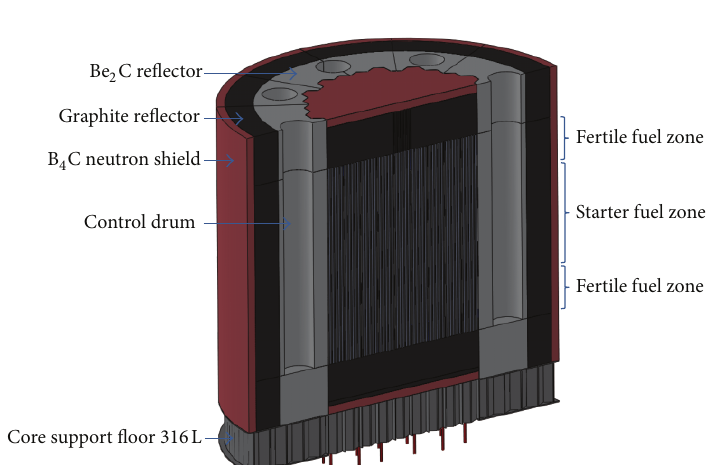
Figure 4: EM 2 reactor system.